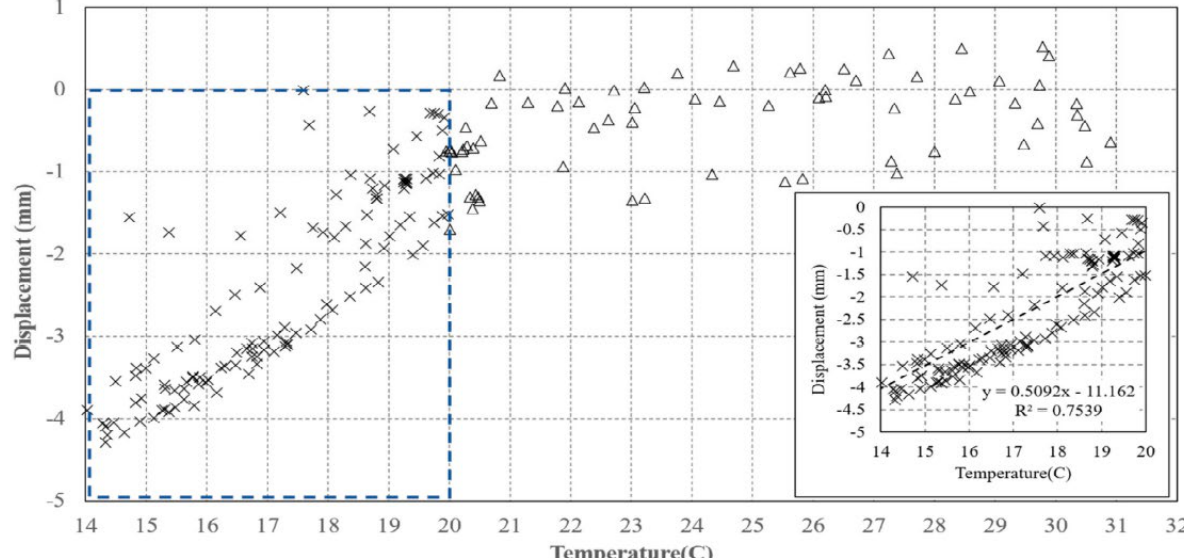
Figure 9. Displacement of the AR versus temperature measured during the calibration test. The box on the left includes a model of the data in the temperature range between 14 and 20 ºC. After Luzi et al.